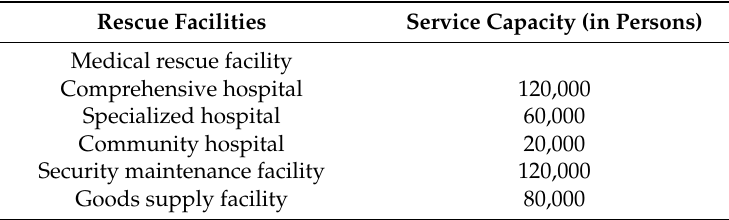
Table 1. Service Capacity Standard for Public Rescue Facilities.